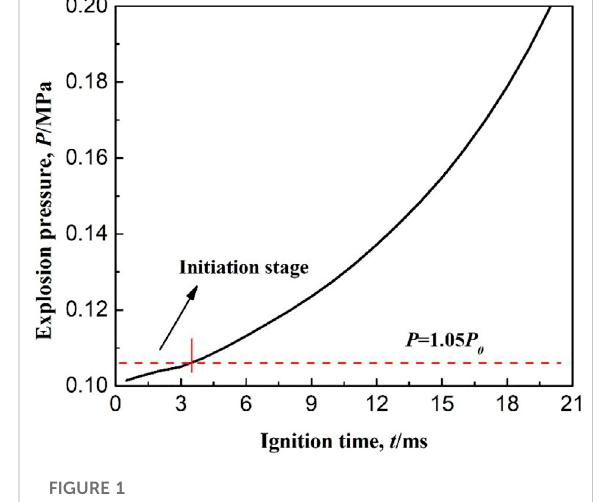
FIGURE 1 De fi nition of the ignition initiation stage.